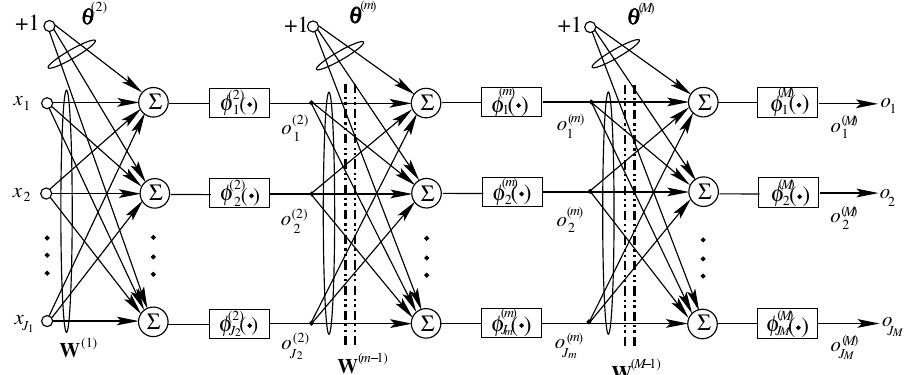
Figure 3. Architecture of the MLP. The MLP has M layers. The m th layer has J m